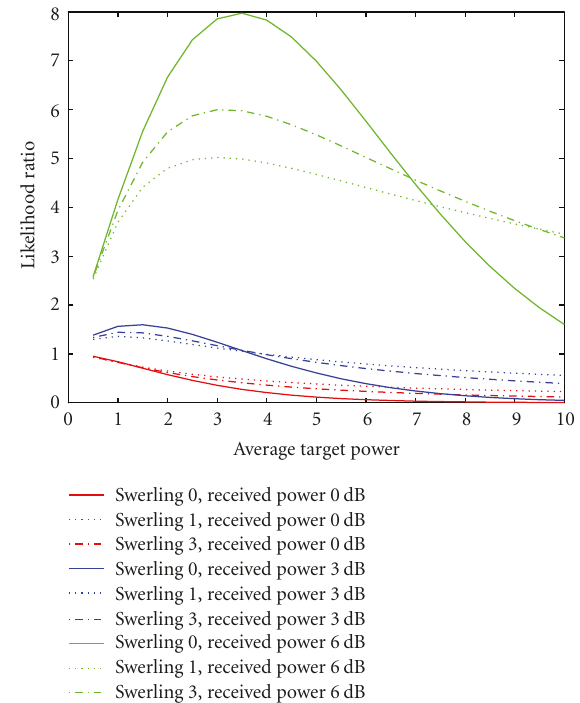
Figure 7: Variation of calculated likelihood ratio against postulated average target power for received measurement powers of 0dB, 3dB and 6dB above clutter power. Curves are shown for Swerling 0, 1, and 3 target